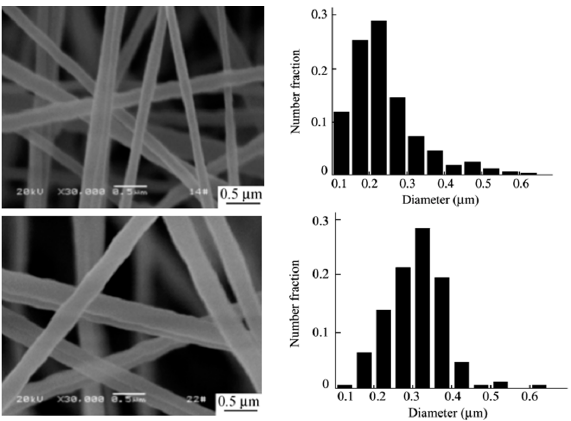
Figure 11. Effect of spinning distance (Top = 19 cm and Bottom = 15 cm) on the average fiber Figure 11. E ff ect of spinning distance (Top = 19 cm and Bottom = 15 cm) on the average fiber diameter diameter and its distribution for PS nanofibers, adapted from reference [216] . and its distribution for PS nanofibers, adapted from reference